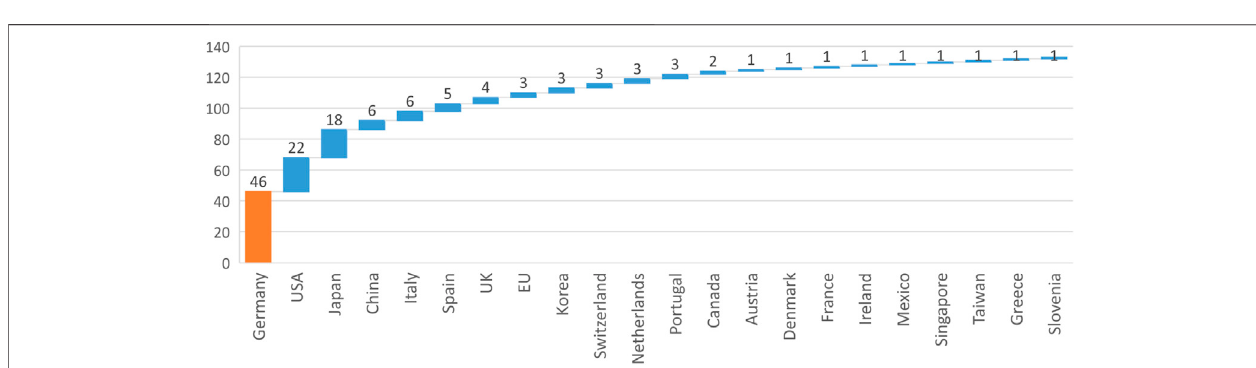
FIGURE 6 | Number of projects found per